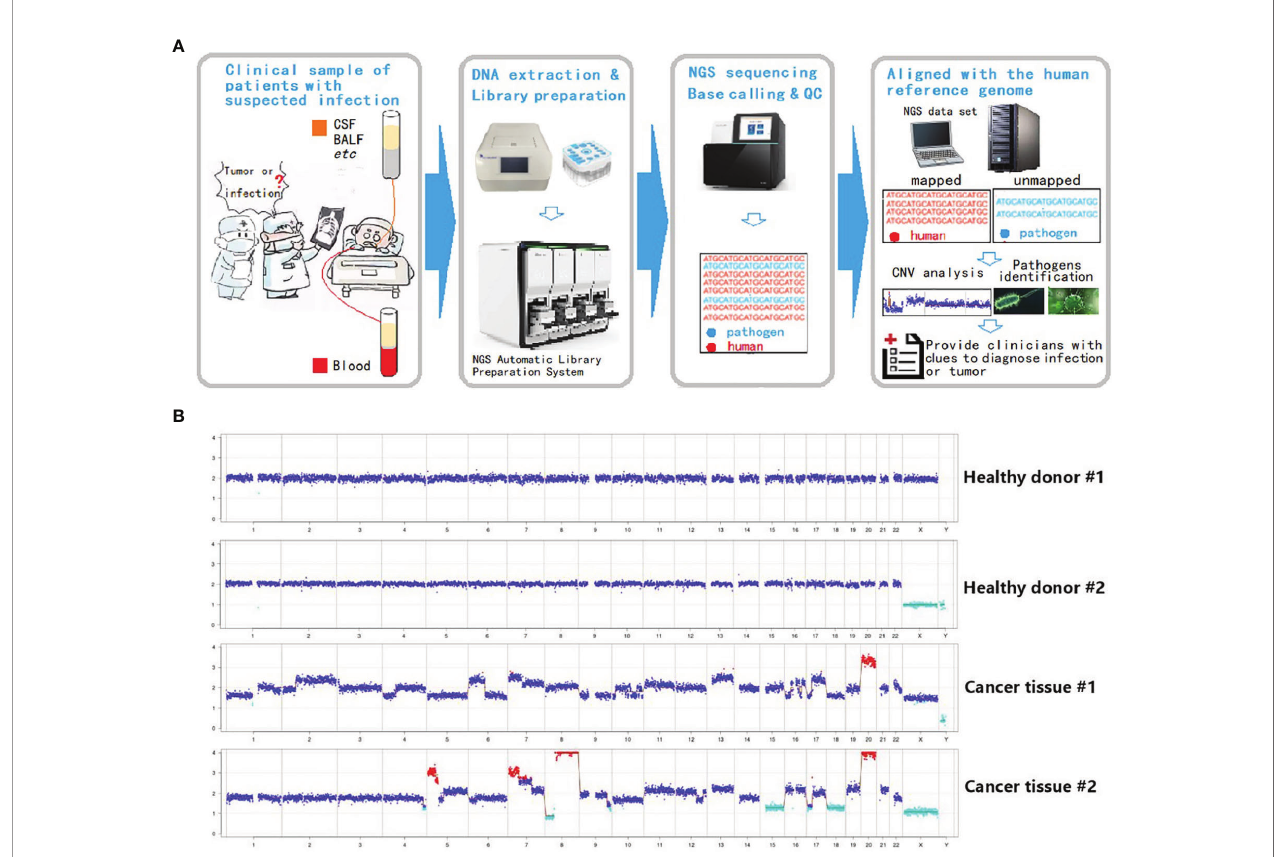
FIGURE 2 | Integration of CNV analysis with mNGS to detect tumors. (A) Onco-mNGS procedure. (B) CNV data derived from peripheral blood from two healthy donors and two patients with colorectal cancer. Abbreviations: CSF: cerebrospinal fl uid; BALF: bronchoalveolar lavage fl uid; CNV: copy number variation. Red dots mean the copy number is greater than 2.7; light blue dots mean the copy number is less than 1.3; dark blue dots mean the number of copies is between